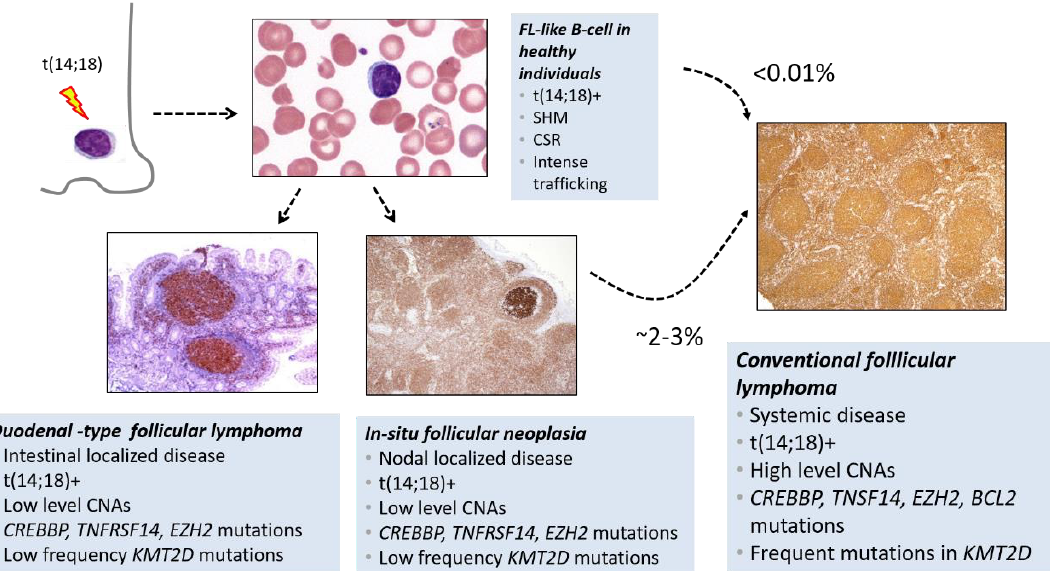
Figure 2. Incipient follicular lymphoma (FL) includes FL-like B cells found in the peripheral blood at low levels in normal individuals, most commonly after age 50. Tissue manifestations of incipient FL include in situ follicular neoplasia and duodenal-type FL. Abbreviations. CNAs, chromosomal numeric aberrations; SHM, somatic hypermutations; CSR: Class switch recombination. Reproduced with permission from Jaffe and Quintanilla-Martinez [7].